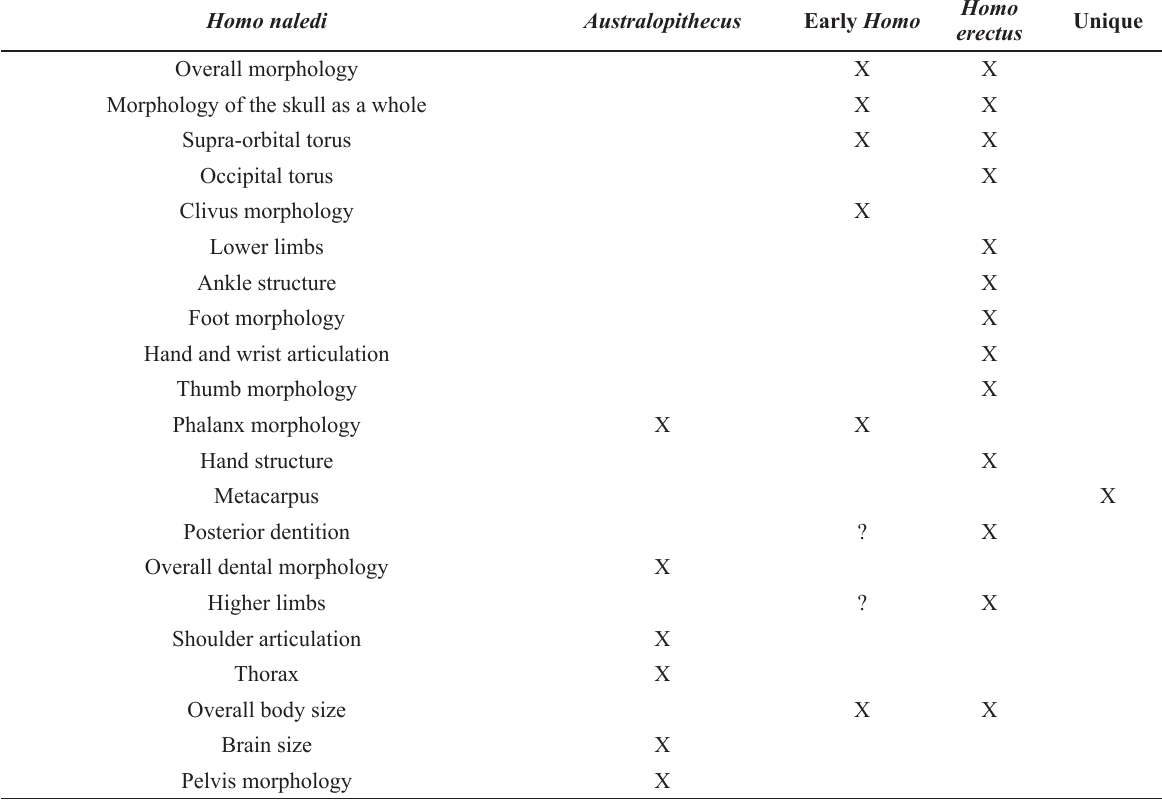
Anatomical traits of H. naledi as compared to other Plio-Pleistocene hominins as expressed by Berger et al. (2015). Homo